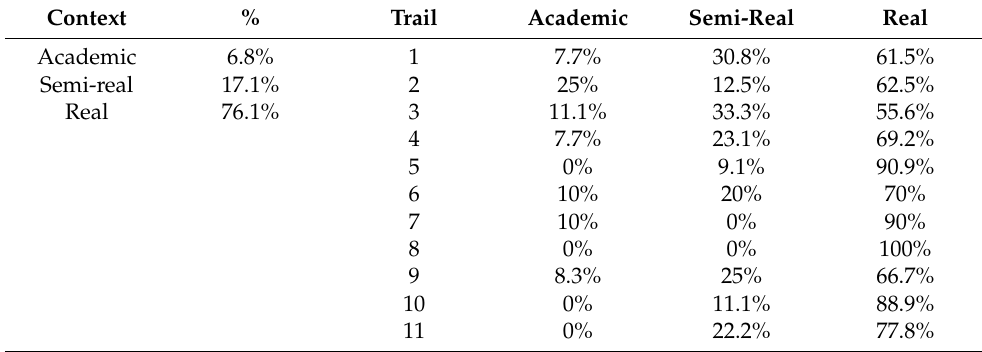
Table 7. Academic, semi-real and real tasks ( Context ) and breakdown for each trail. Context